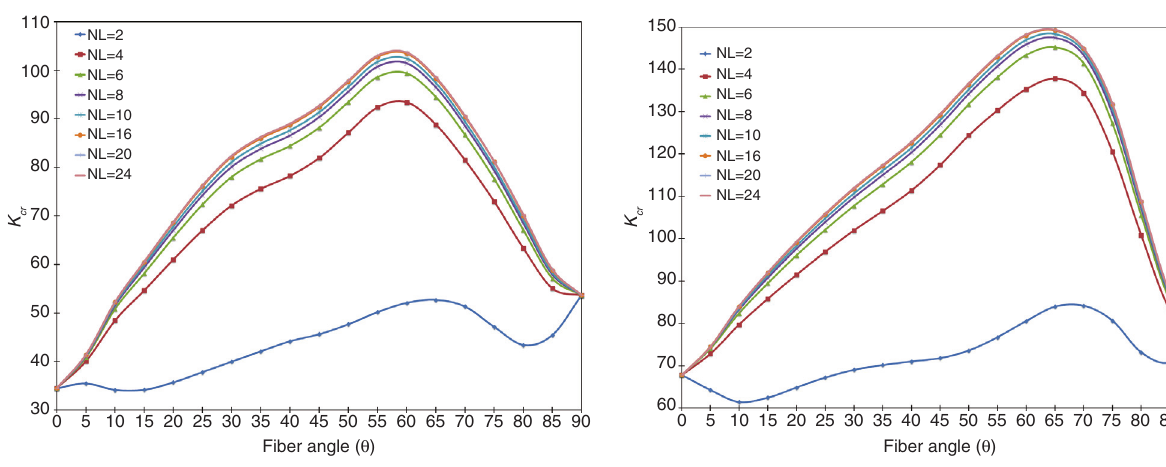
Figure 4 Critical buckling load parameter for simply supported antisymmetric cylindrical skew panel (Ø = 15 ° , α = 15 ° ).